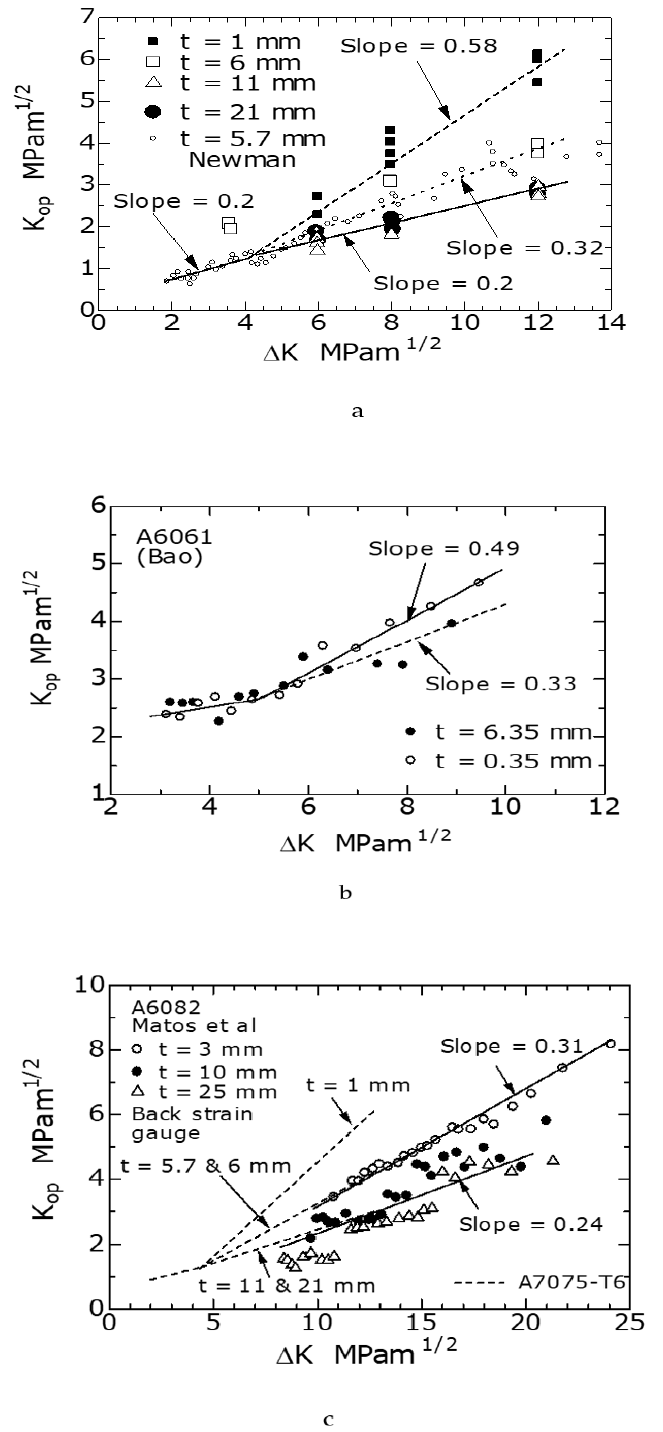
Figure 7. Effect of ∆ K on the stress intensity factor at the crack opening level K op for ( a ) Figure 7. Effe ct of ΔK on the stress intensity factor at the crack opening level K op for ( a ) A7075-T6;